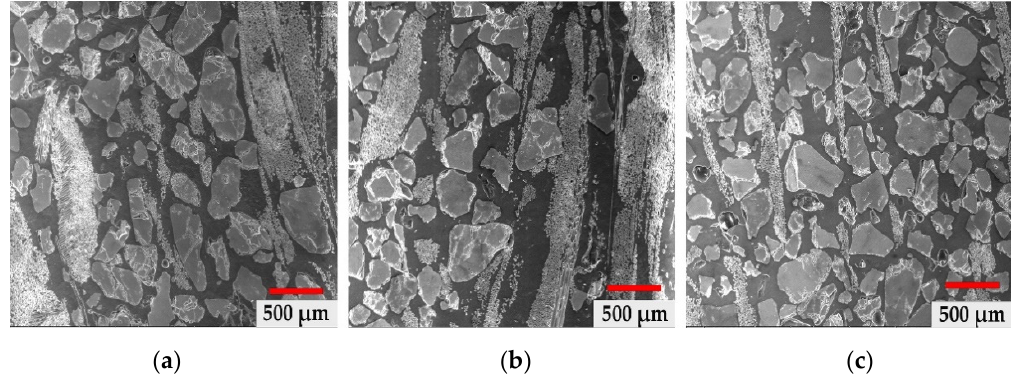
Figure 3. Morphological structure of the material core: ( a ) neutral soil, ( b ) basic soil, ( c ) acidic soil.